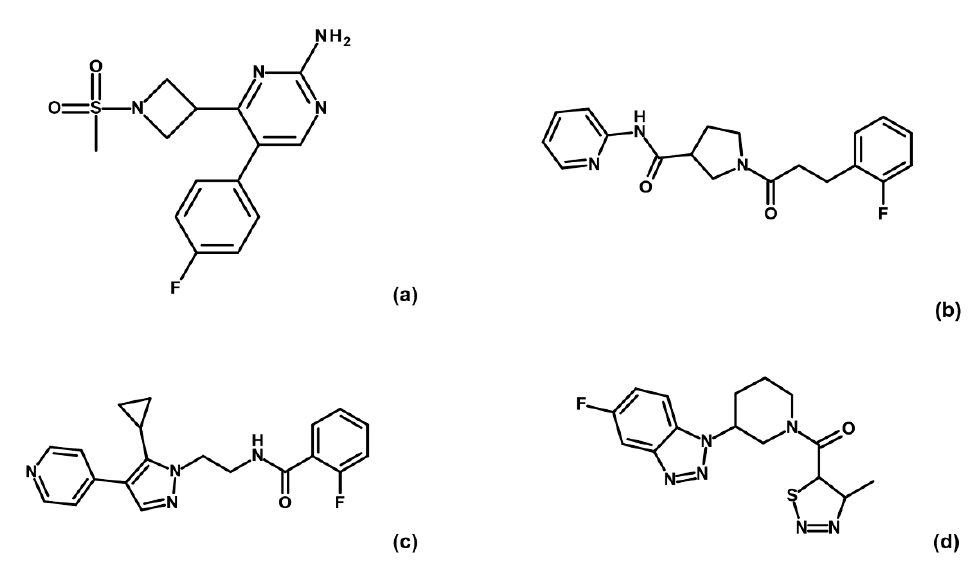
Figure 3. Chemical structures of fragments G5 ( a ), G12 ( b ), B3 ( c ) and E2 ( d ).